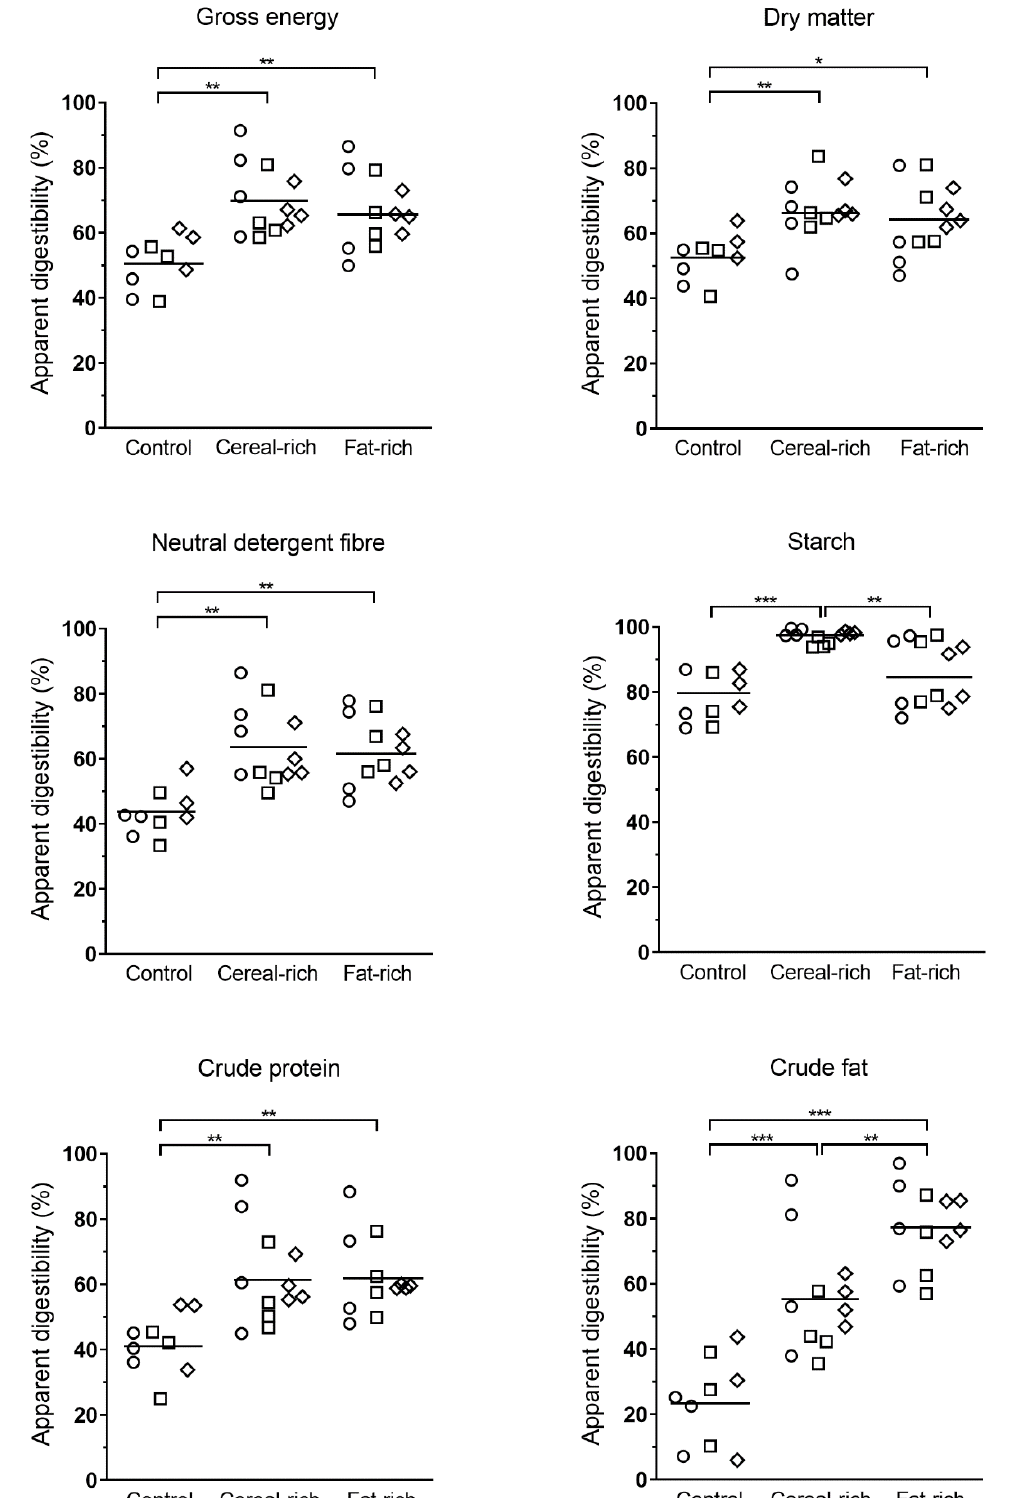
Figure 1. Apparent total tract digestibility of nutrients in Standardbred horses (circles), ponies (squares) and Andalusian horses (diamonds) adapted to eating a fibre-based control diet, hypercaloric cereal-rich diet or hypercaloric fat-rich diet over 20 weeks. No effect of breed was detected for any nutrient (all p > 0.05). Horizontal lines indicate diet group means. Pairwise comparisons performed between diet groups with Bonferroni correction (* p < 0.05, ** p < 0.01, *** p < 0.001).